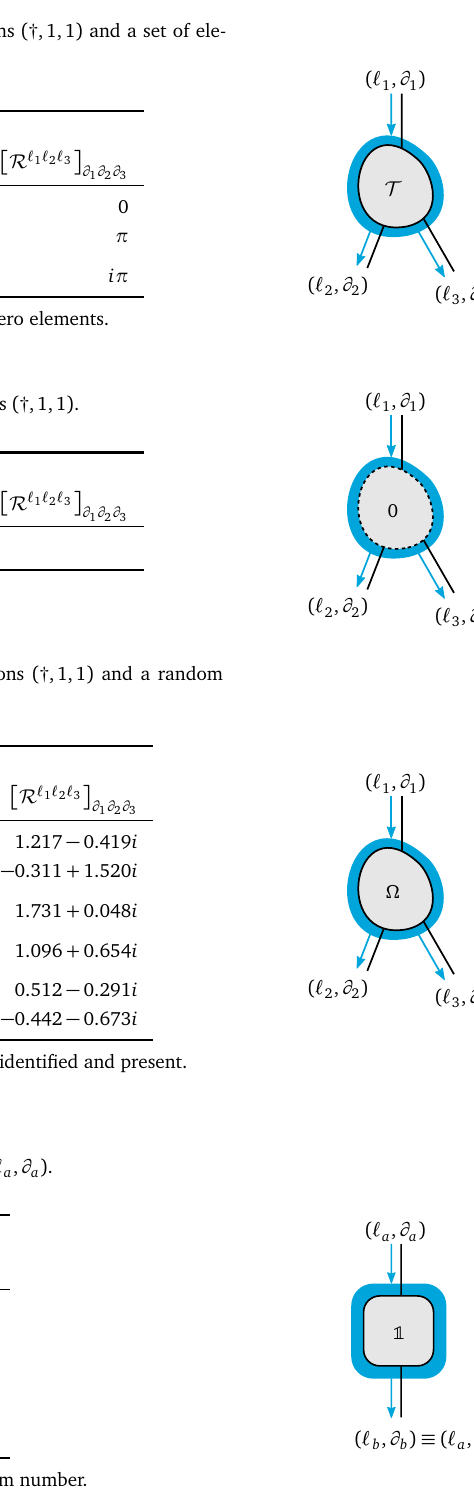
) , ( (cid:96) ) , ( (cid:96) ) as in Fig. 15. (A) from user provided , ∂ , ∂ , ∂ 1 1 2 2 3 3 ) : = ( (cid:96) ) , ∂ , ∂ a a 1 1